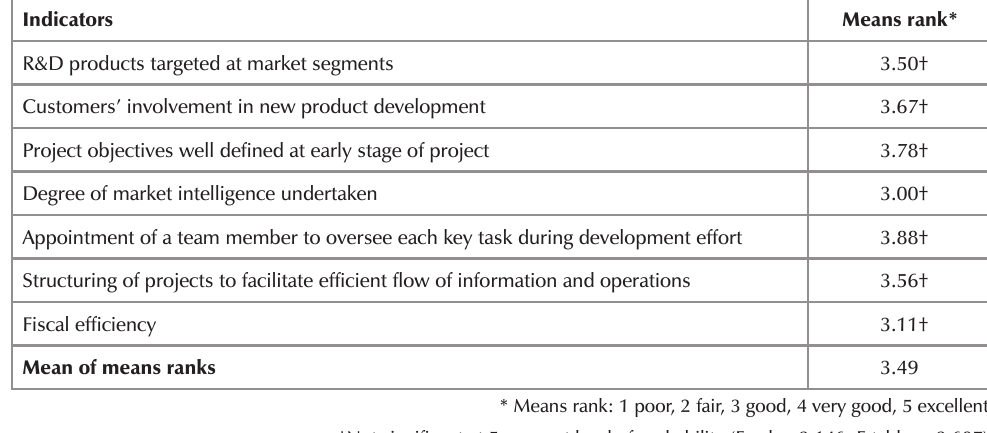
Effectiveness of managing business development in the R&D